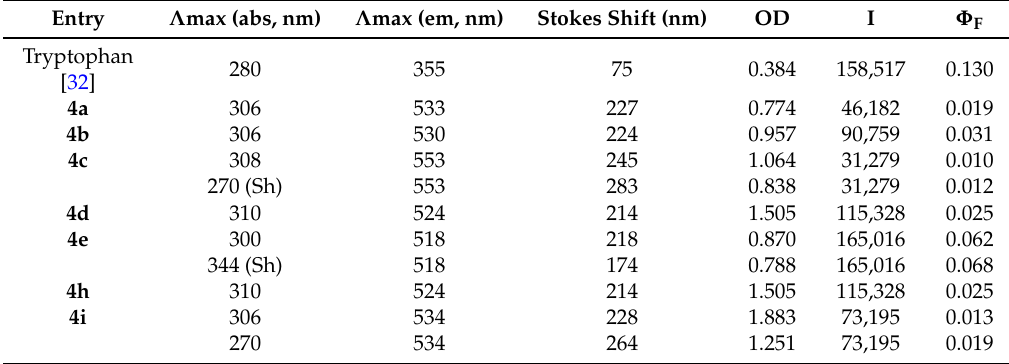
Table 7. The optical properties of the synthesized pyrimido[1,2- b ]indazolederivatives 4 ( a – p ).